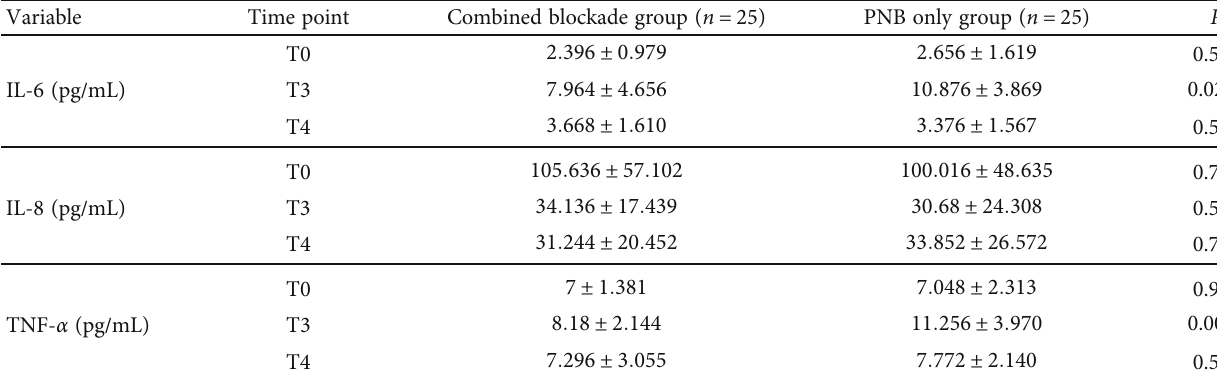
Table 2: Plasma concentration of IL-6, IL-8, and TNF- α